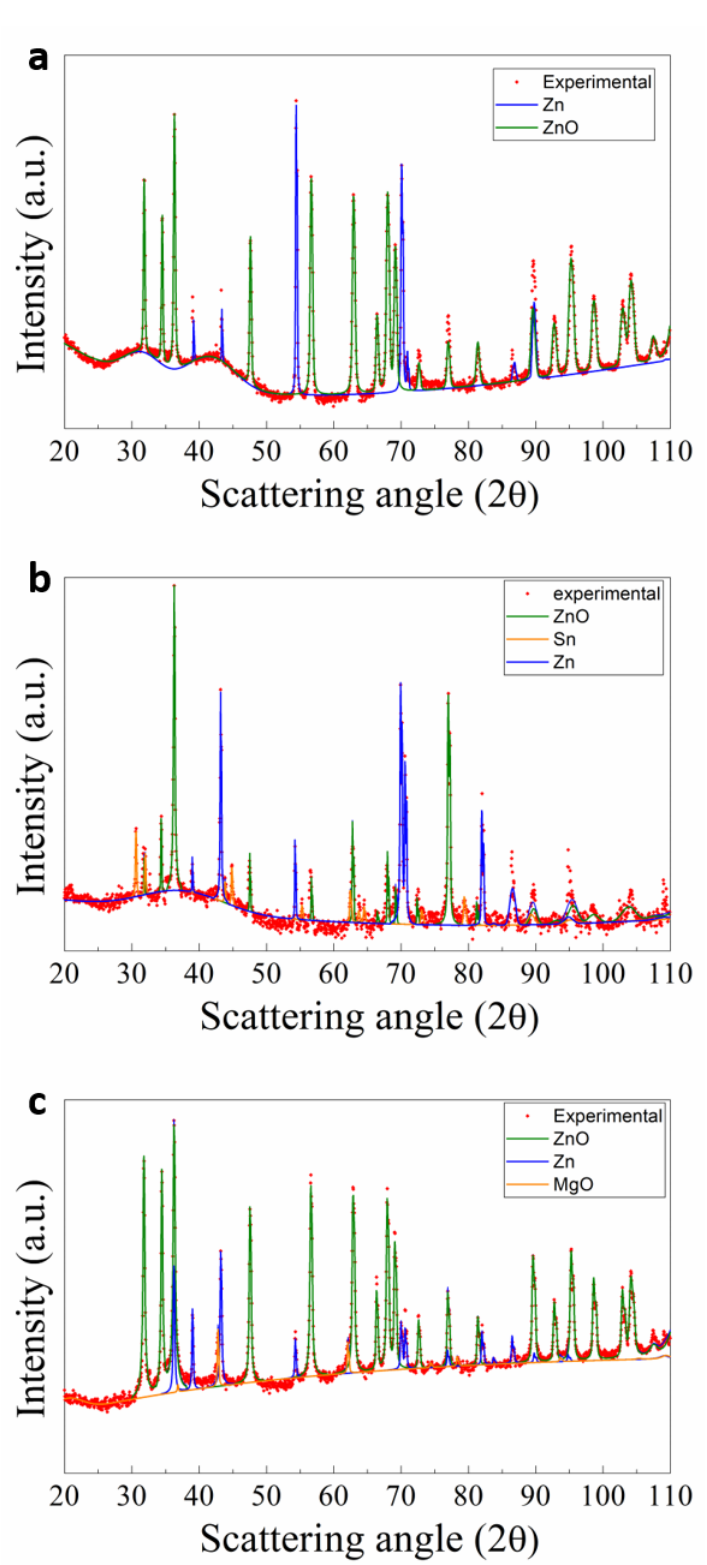
Figure 4. XRD patterns and the corresponding Rietveld fit profiles of ( a ) A, ( b ) B-Sn, and ( c ) C-Mg samples.